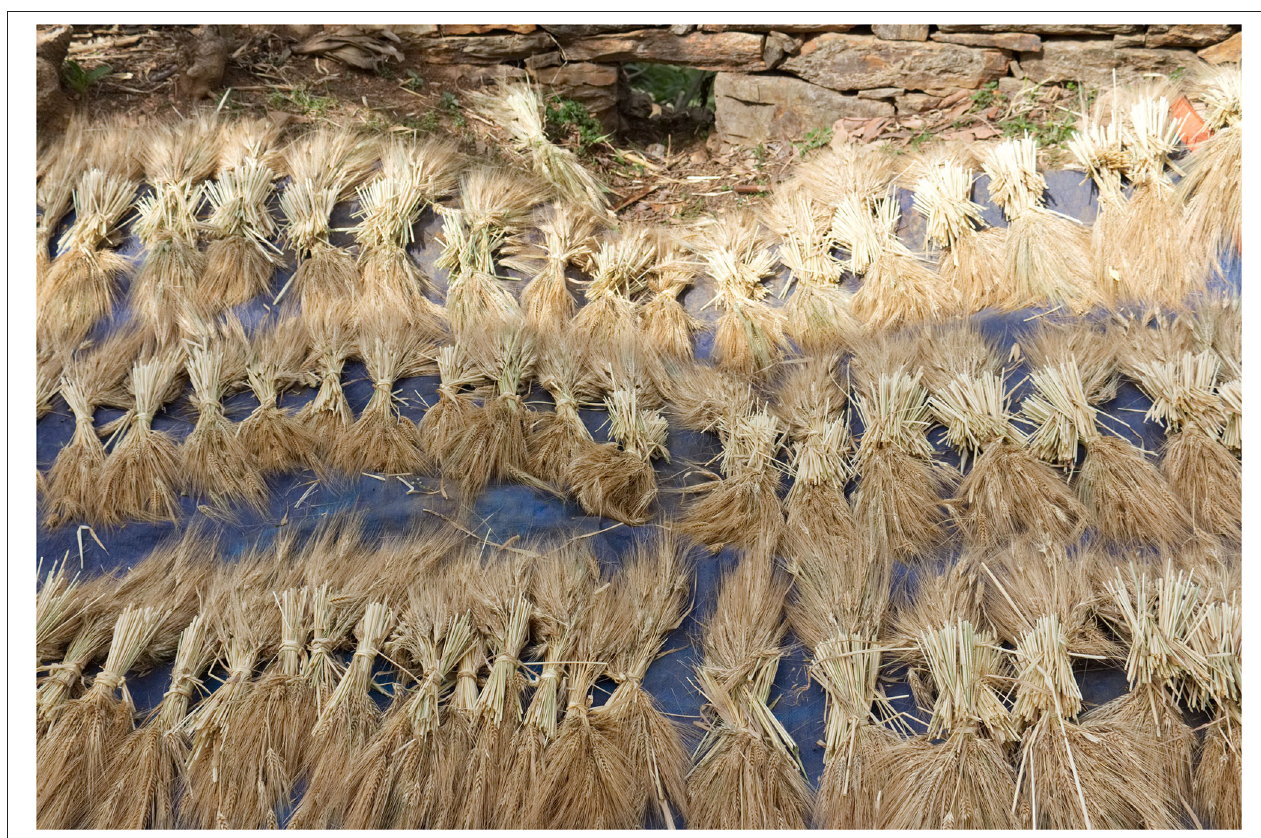
FIGURE 4 | Barley harvest sorted and left to